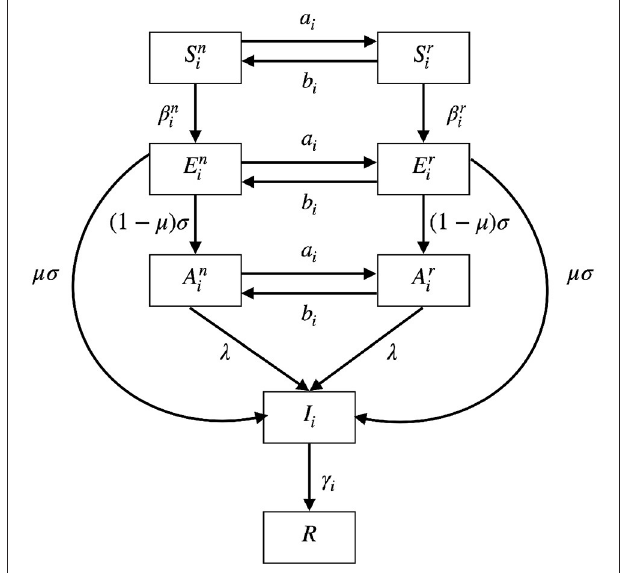
FIGURE 2 | A schematic diagram of Model (5). S represents susceptible compartment; E represents exposed compartment; A represents asymptomatic compartment; I represents infected compartment; R represents recovered compartment. The populations can interchange between normal